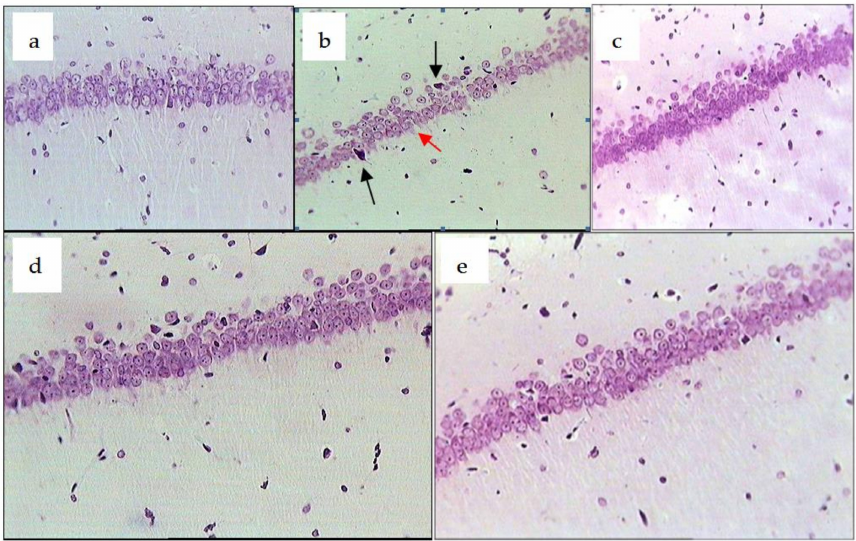
Figure 5. Dorsal hippocampus (CA1, ipsilateral side) in rats exposed to chronic emotional stress (CES). Experimental groups: intact, no CES ( a ); CES, decreased neuron density of the pyramidal layer ( b ); black arrow–necrosis of neuron, red arrow–autolysis; CES + R. uniflorum ( c ); CES + S. centauroides ( d ); CES + R. carthamoides ( e ). Stained with cresyl-violet. Magnification ×